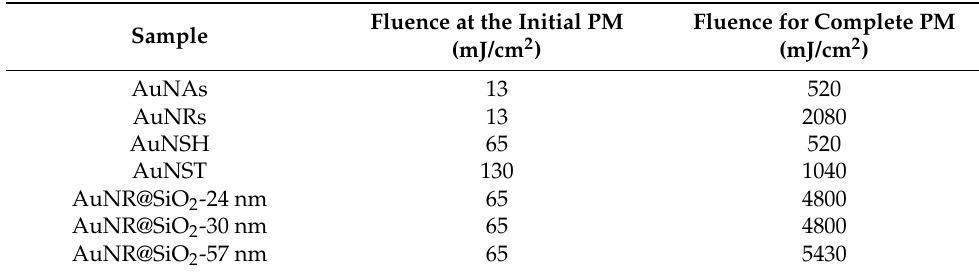
Table 1. Fluence threshold values for the beginning and end of photomodification for various types of gold and silica-coated gold nanoparticles, obtained from extinction